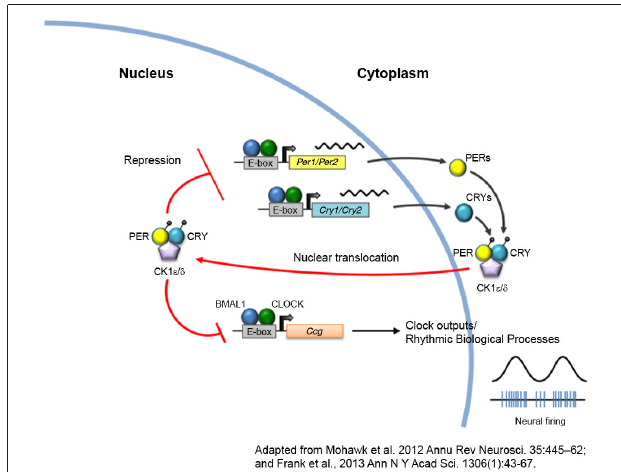
FIGURE 1 | The circadian clock machinery . Twenty-four hour rhythms are generated by a cell-autonomous and autoregulatory transcriptional-translational feedback loop. In its simplest form, the core circadian protein, CLOCK, forms a complex with brain and muscle ARNT-like protein 1 (BMAL1). This complex binds to enhancer box (E-box) regulatory element and activates transcription of the Period (Per) and Cryptochrome ( Cry ) genes. As PERs and CRYs accumulate during the day, they dimerize and translocate back to the nucleus where they interact with CLOCK and BMAL1 to repress their own transcription. As these negative elements are degraded by casein kinases (CK) at night, repression of CLOCK and BMAL1 is removed, and a new cycle of transcription begins the following morning. The CLOCK-BMAL1 complex also binds to an array of clock-controlled genes ( ccg ) that ultimately regulate biological processes such as sleep-wake cycles, body temperature, hormone secretion, feeding, and activity (modified from an original by Mohawk et al., 2012; Frank et al.,